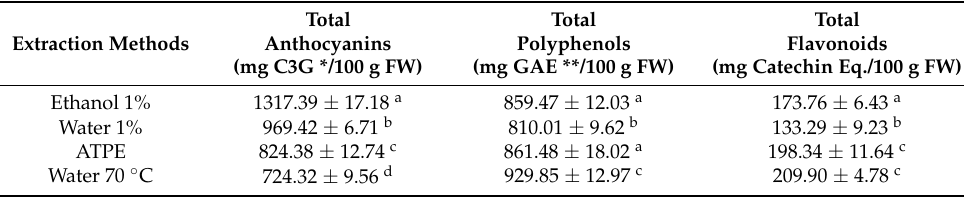
Table 1. Content of antioxidant bioactive substances of H. macrocarpa